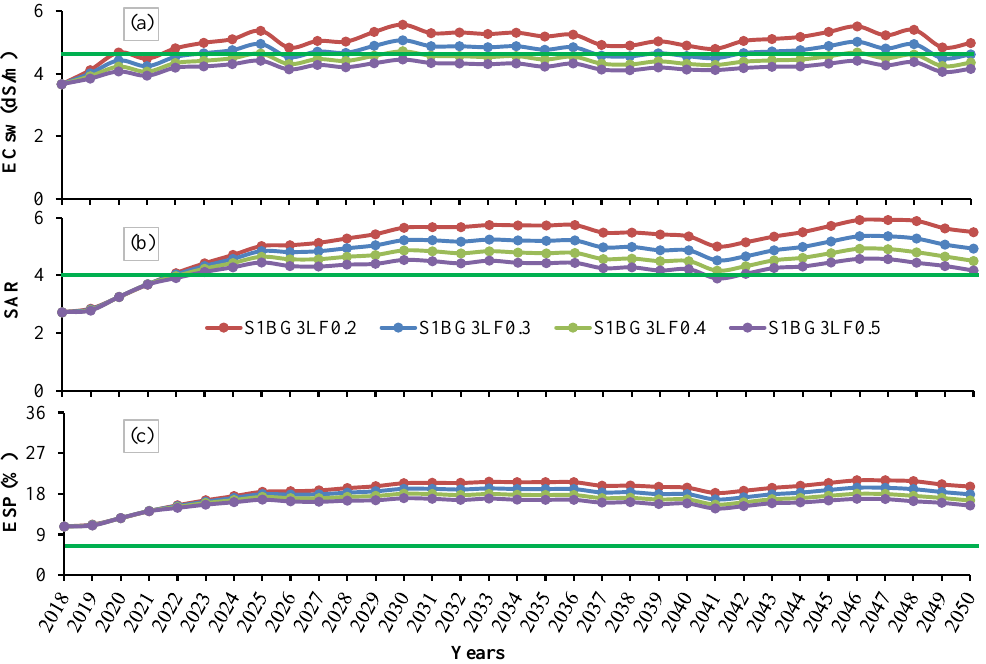
Figure 6. Impact of different leaching fractions (LF0.2, LF0.3, LF0.4, and LF0.5) and annual gypsum applications of 8.6 t/ha (G3) on ( a ) EC sw , ( b ) SAR, and ( c ) ESP in the 30–60 cm soil layer of the calcareous soil (S1) under a 1:1 blend of recycled (RW) and good water (GW) irrigation of wine grapes.